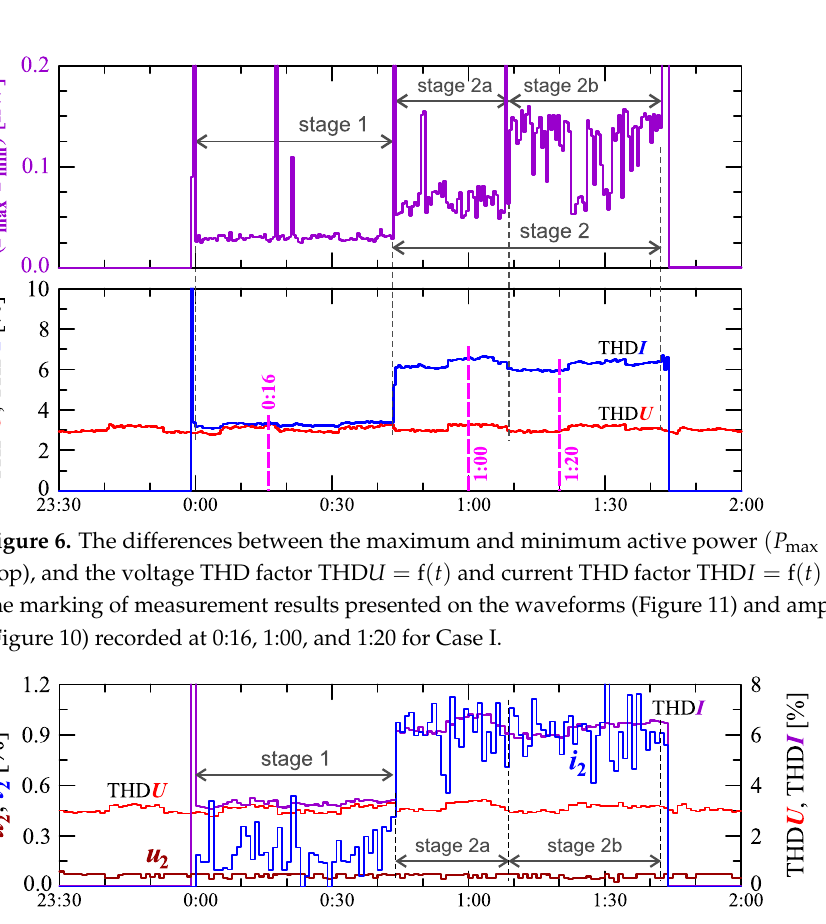
Figure 7. The characteristics of the voltage THD factor THD U = f ( t ) and the current THD factor THD I = f ( t ) and the characteristics of the second harmonics of the current i 2 = f ( t ) and voltage u 2 = f ( t ) for Case